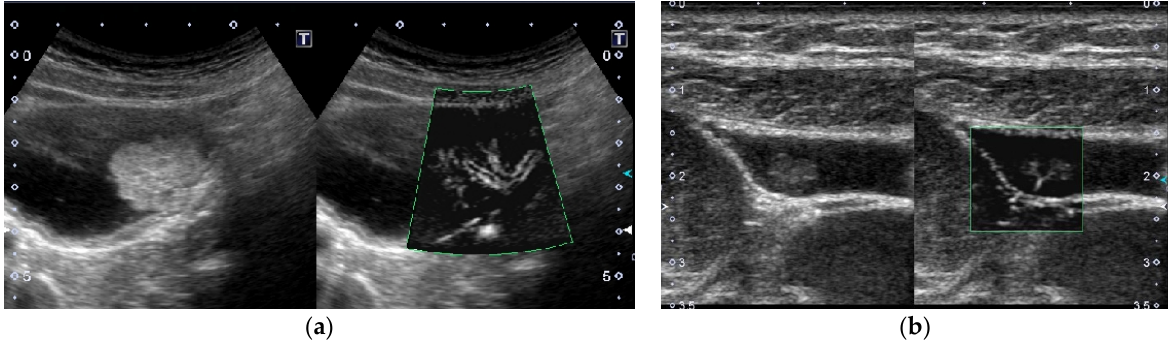
Figure 10. Vascular imaging using superb microvascular imaging (SMI). ( a ) Multiple flow signals spreading dendritically from the base into the lesion were delineated in a GBC. ( b ) A branched signal was detected in a cholesterol polyp.